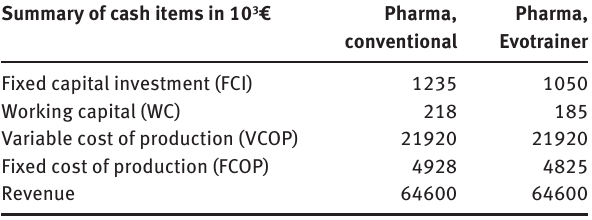
Table 9 Summary of cash flow items for the naproxen